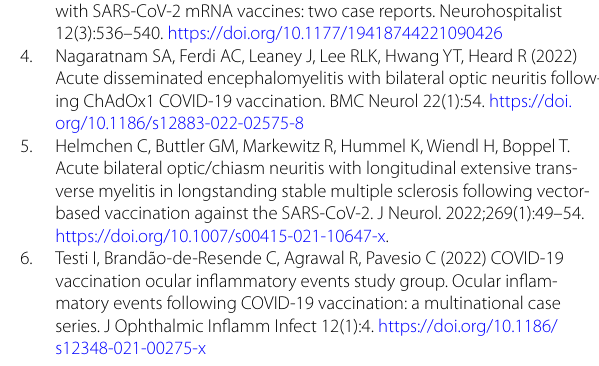
herpetic keratitis, Iridocy-